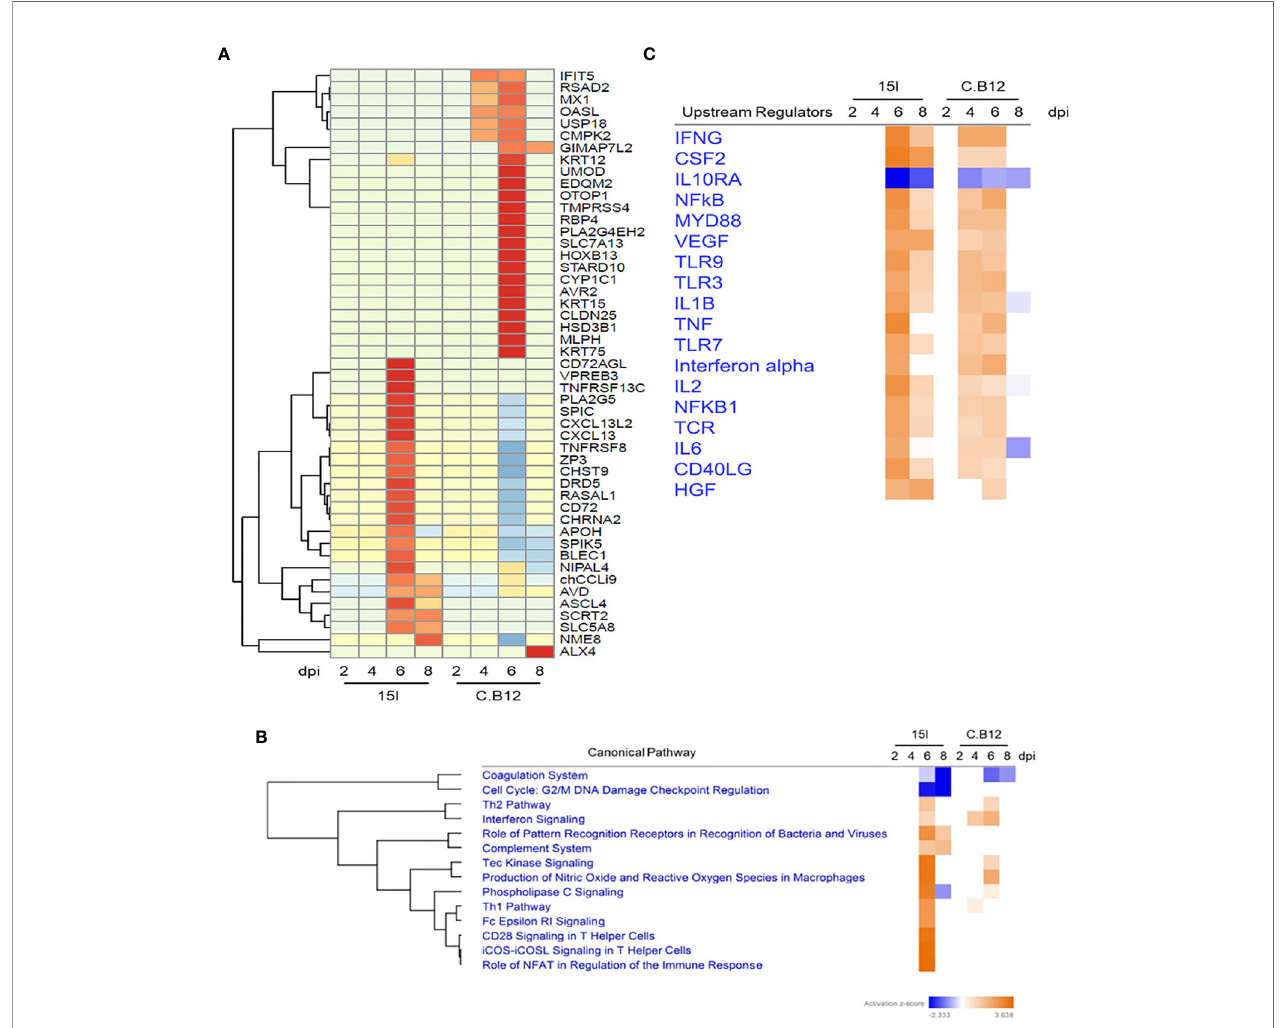
FIGURE 4 | Comparison of line 15I and C.B12 chickens during E . maxima infection. Heatmap (A) showing genes that presented the highest mean fold difference between lines. Functional pathway analysis (B) and predicted upstream regulators in both lines (C) are presented with color based on Z-score; orange indicating activated pathways or regulators and blue indicating de-activated pathways or